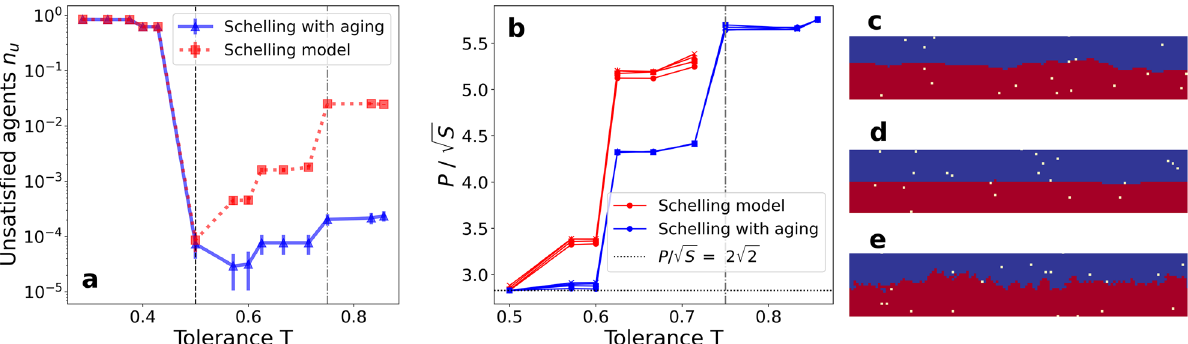
Figure 2. ( a ) Fraction of unsatisfied agents n u at the stationary regime as a function of the tolerance parameter T . ( b ) Measure of the interface roughness between clusters of different kind of agents at the final stationary 40 state P / √ S as a function of the tolerance parameter T . Different markers indicate different system sizes: L = (circles), 60 (squares), 80 (triangles) and 100 (crosses). Results are shown for both the Schelling model with and 10 4 realizations. The 0.5% and averaged over 5 without aging. Numerical simulations are performed for ρ v · = frozen-segregated transition (dashed black line) and the segregated-mixed transition (gray dot-dashed line) are highlighted to differentiate the phases that the Schelling model exhibits. There are no values of P / √ S for the 3 / 4 because the segregated-mixed transition occurs. ( c ) Final state interface zoom Schelling model above T = 0.57 using the original model. ( d ) Final state interface zoom snapshot for T 0.57 using the snapshot for T = = 0.86 model with aging. ( e ) Same as c for T =